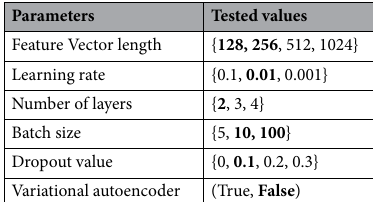
Table 2. The seq2seq model’s parameter optimization, bold fonts indicate the selected values.